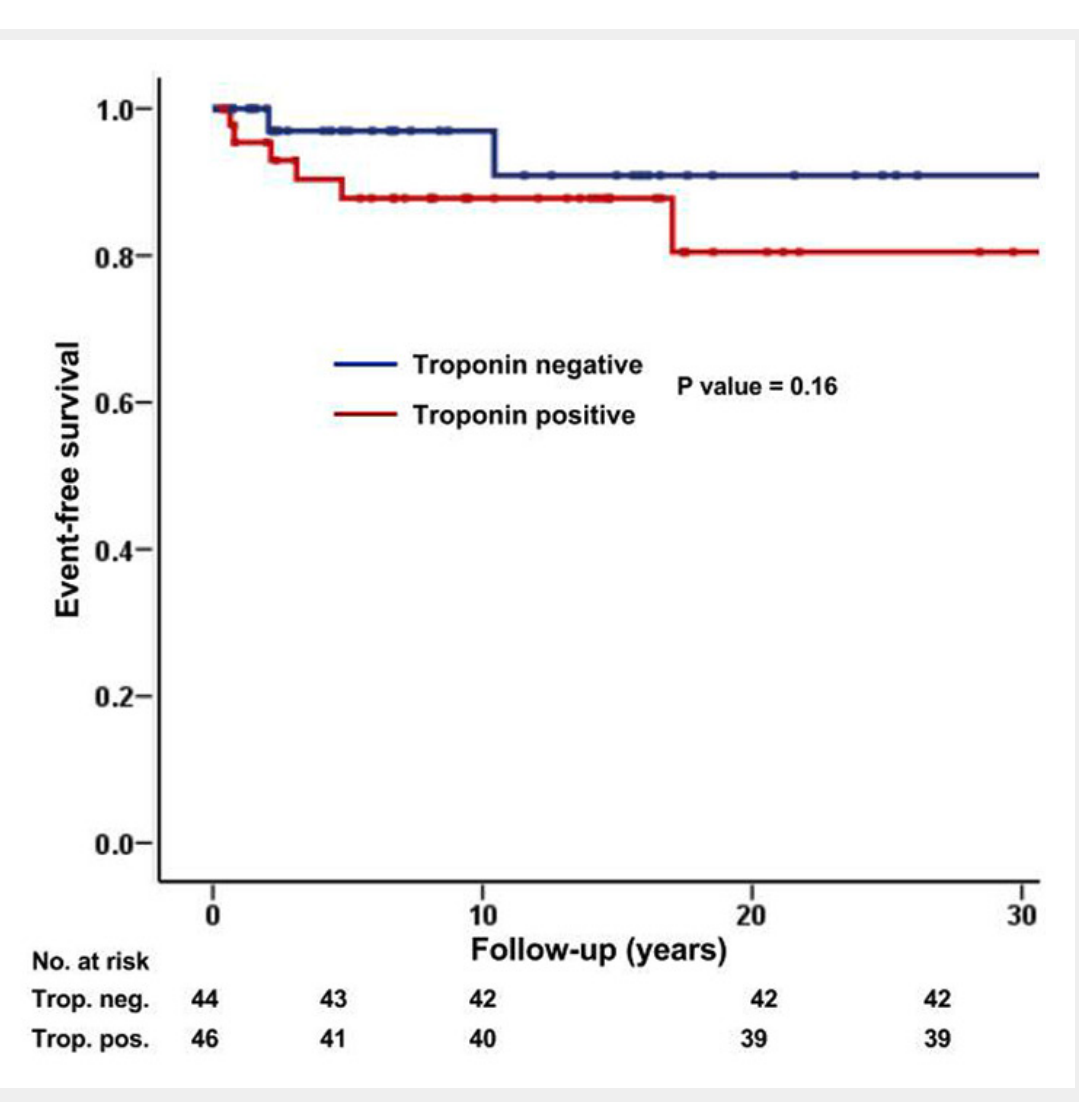
Figure 2 Kaplan-Meier analysis for estimation of event-free survival according to elevated (red line) or normal (blue line) hs-cTnT levels. Although patients with raised hs-cTnT levels showed a trend towards more events, it did not reach statistical significance (p =